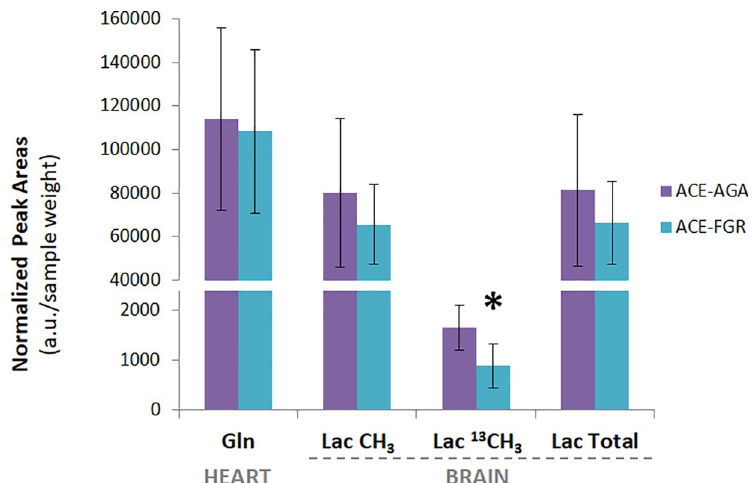
Fig 4. Quantification of heart glutamine and brain lactate pools of the ACE group. Values are displayed as metabolite peak areas normalized to sample weight (average ± SD), determined from 1 H-CPMG spectra acquired at 34 min of HRMAS time (Fig 3A). Sample sizes (n): heart glutamine, 6 AGA and 5 FGR; brain lactate, 5 AGA and 6 FGR. Significant differences between FGR and AGA fetuses detected only for the estimated 13 C-labelled lactate pool ( � p < 0.05, two-tailed unpaired t-Test), calculated as 2 � ½ Lac 13 CH 3. Lac Total = Lac CH 3 + Lac 13 CH 3 .